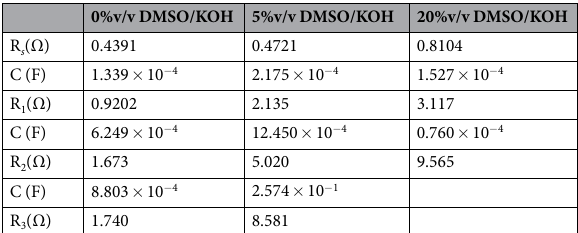
Table 2. The obtained parameters from fitting of EIS